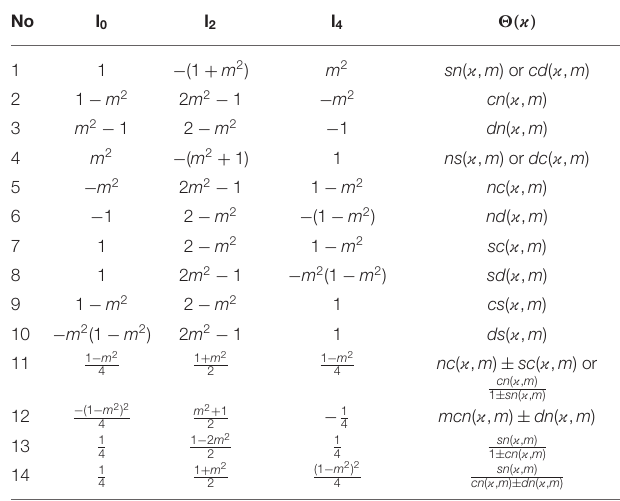
TABLE 1 | Jacobi elliptic solutions of Equation